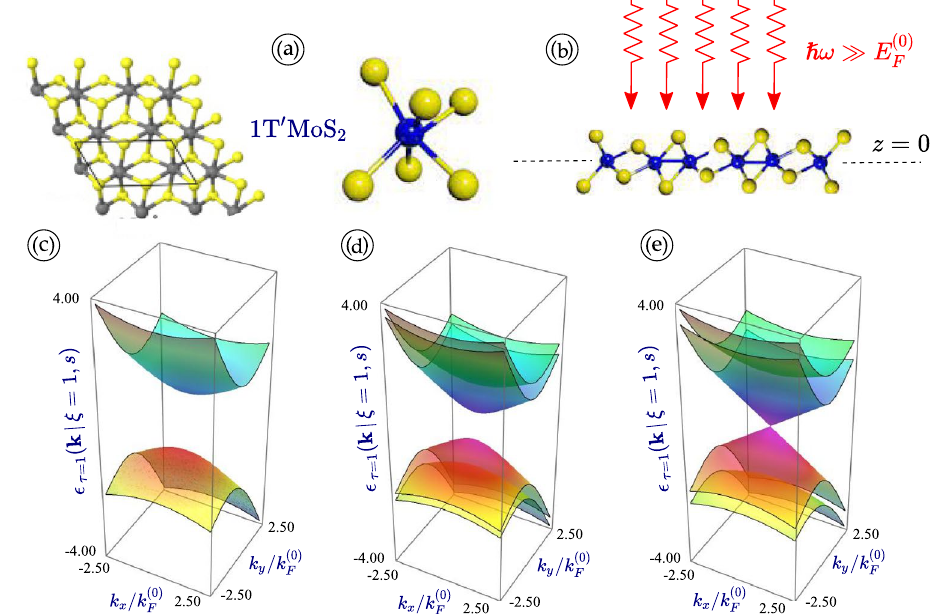
0 in the absence Figure 1. (Color online) Panels ( a )-( b ) illustrate a two-dimensional 1T ′ -MoS 2 material at z = [( a )] and presence [( b )] of an incident optical field, respectively. On the other hand, panels ( c )-( e ) display valley- k 1, s ) for 1T ξ and spin-polarized energy dispersions ε τ 1 ( ′ -MoS 2 with a finite spin-orbit coupling gap | = =± (cid:31) 0 in the absence of optical-dressing field, where three panels correspond to different values of the external 1 for all three cases. Panels (a) - (d) 0.0 , 0.5, 1.0. Here, we have chosen the valley index ξ electric field r E = = 0.0 , as correspond to the different values of the relative electrostatic field r E =